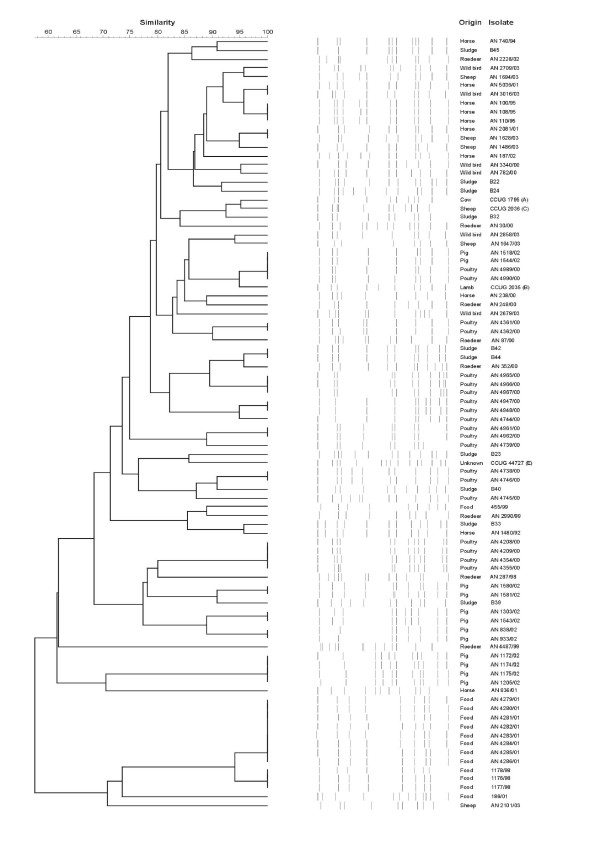
Cluster analysis of SmaI-digested DNA from 88 strains of C. perfringens separated by PFGE.